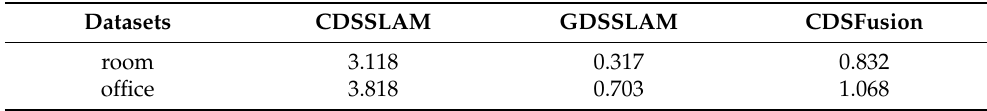
Figure 4. Reconstructed results of the room dataset. ( a ) Semantic map of groundtruth, ( b ) textured map of groundtruth, ( c ) semantic reconstructed result of GDSSLAM, ( d ) semantic reconstructed result of Kimera and ( e ) semantic reconstructed result of our method CDSFusion. Table 6. Time of semantic map generation per frame comparisons between three different methods in